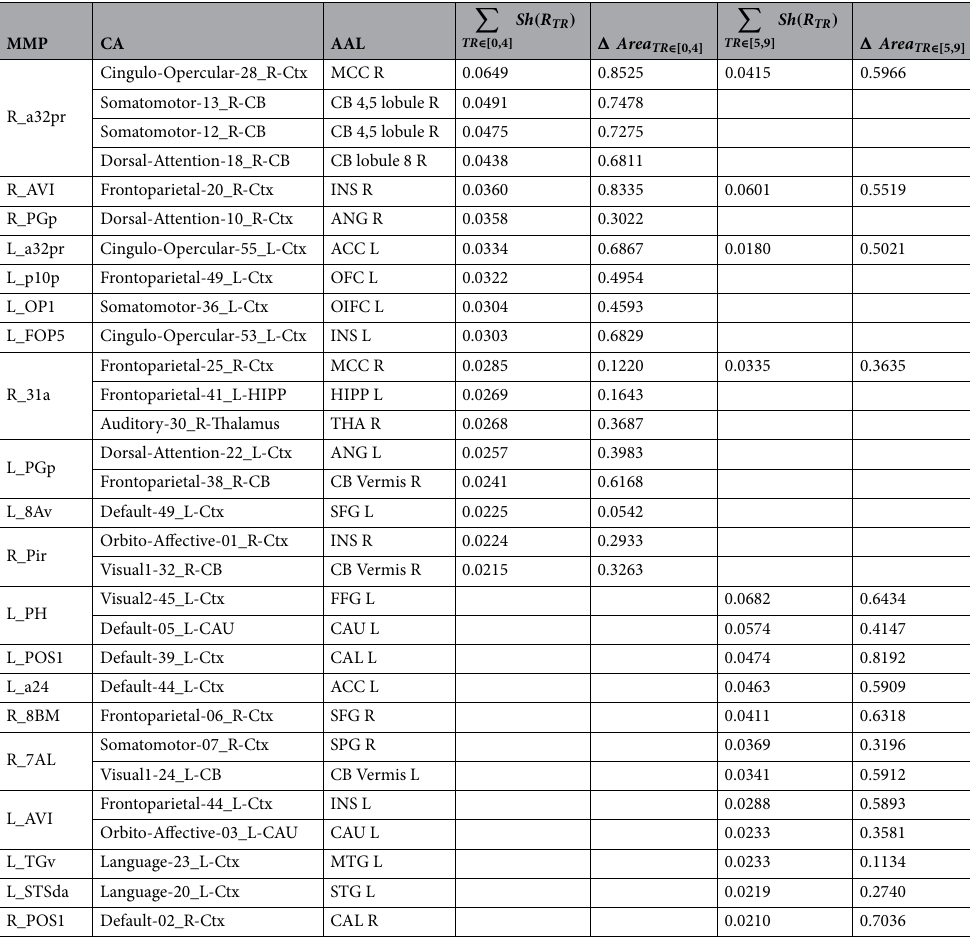
Table 2. The most relevant regions for MMP/CA parcellation POScorr-LURfalse problem with Shapley value Sh sums for the regions R TR found to be most important in the 0–4 TR and 5–9 TR time windows. The mean (cid:31) Area TR area values are given accordingly for TR regions. ACC anterior cingulate cortex, ANG angular